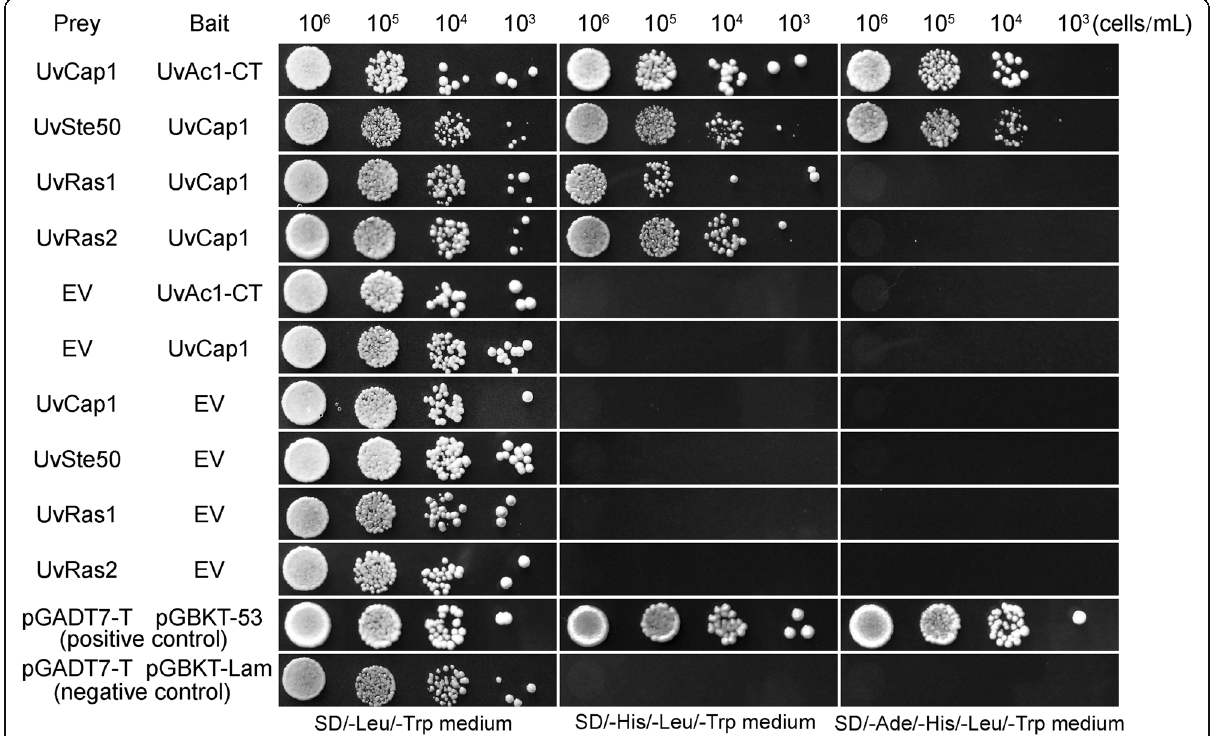
Fig. 6 Assays for interactions between UvCap1 and other proteins in U. virens . A yeast two-hybrid assay was used to examine the interaction between UvCap1 and the C-terminal end of UvAc1, Ras proteins (Ras1 and Ras2) and Uvste50. Yeast cells (10 3 – 10 6 cells/mL) of transformants containing prey and bait vectors were assayed for growth on SD/-Leu/-Trp, SD/-His/-Leu/-Trp and SD/-Ade/-His/-Leu/-Trp. EV, empty